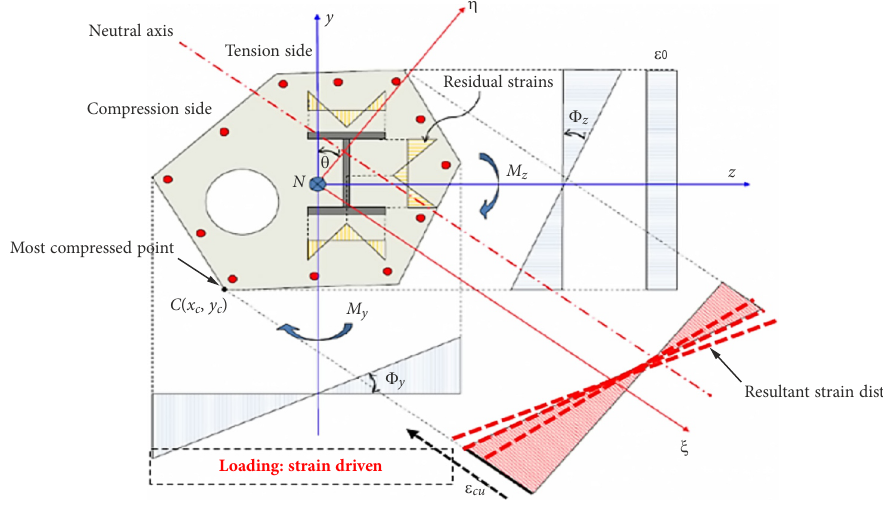
Fig. 1. Model of arbitrary composite cross-section. Strain-driven approach